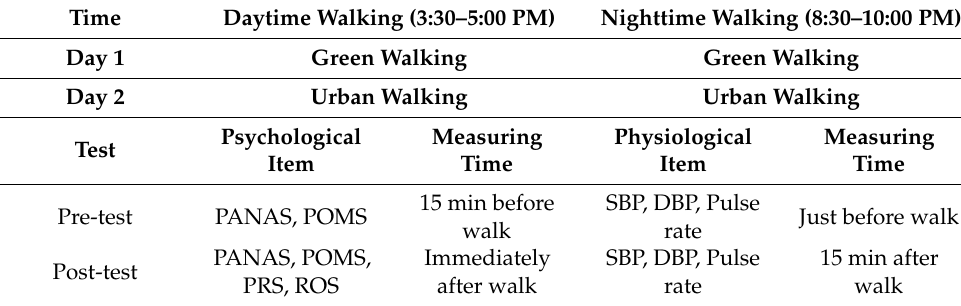
Table 2. Process and test contents of the experiment. Time Daytime Walking (3:30–5:00 PM) Nighttime Walking (8:30–10:00 PM)